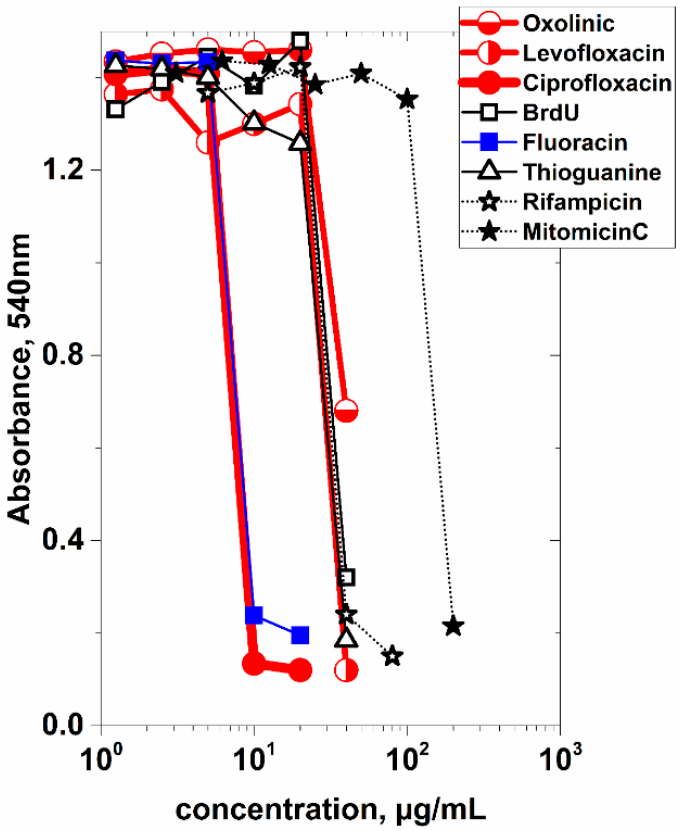
Figure 4. Selection of drugs for inactivation of recombinant E. coli BL21(DE3).